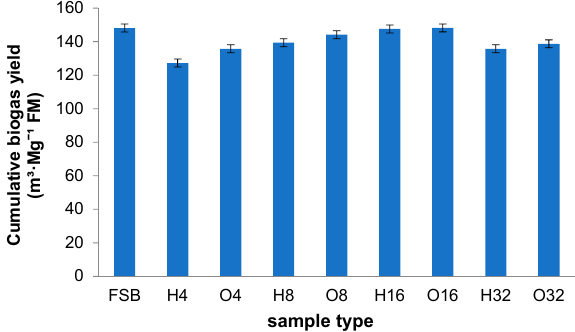
Figure 2. Cumulative biogas yield obtained from 1 mg of fresh matter (FM).